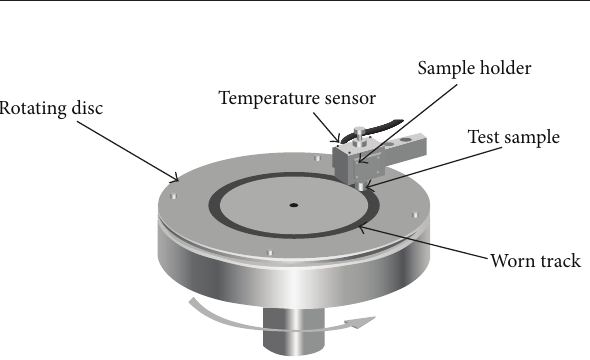
Figure 1: Diagram of pin-on-disk (POD)